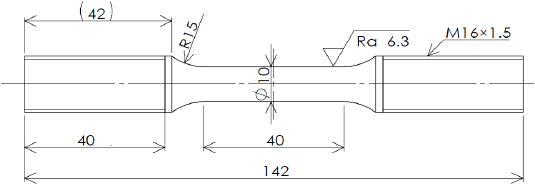
Figure 2. Specimen geometry; all measures are in mm. Table 1. Chemical composition of the mid-carbon steel.